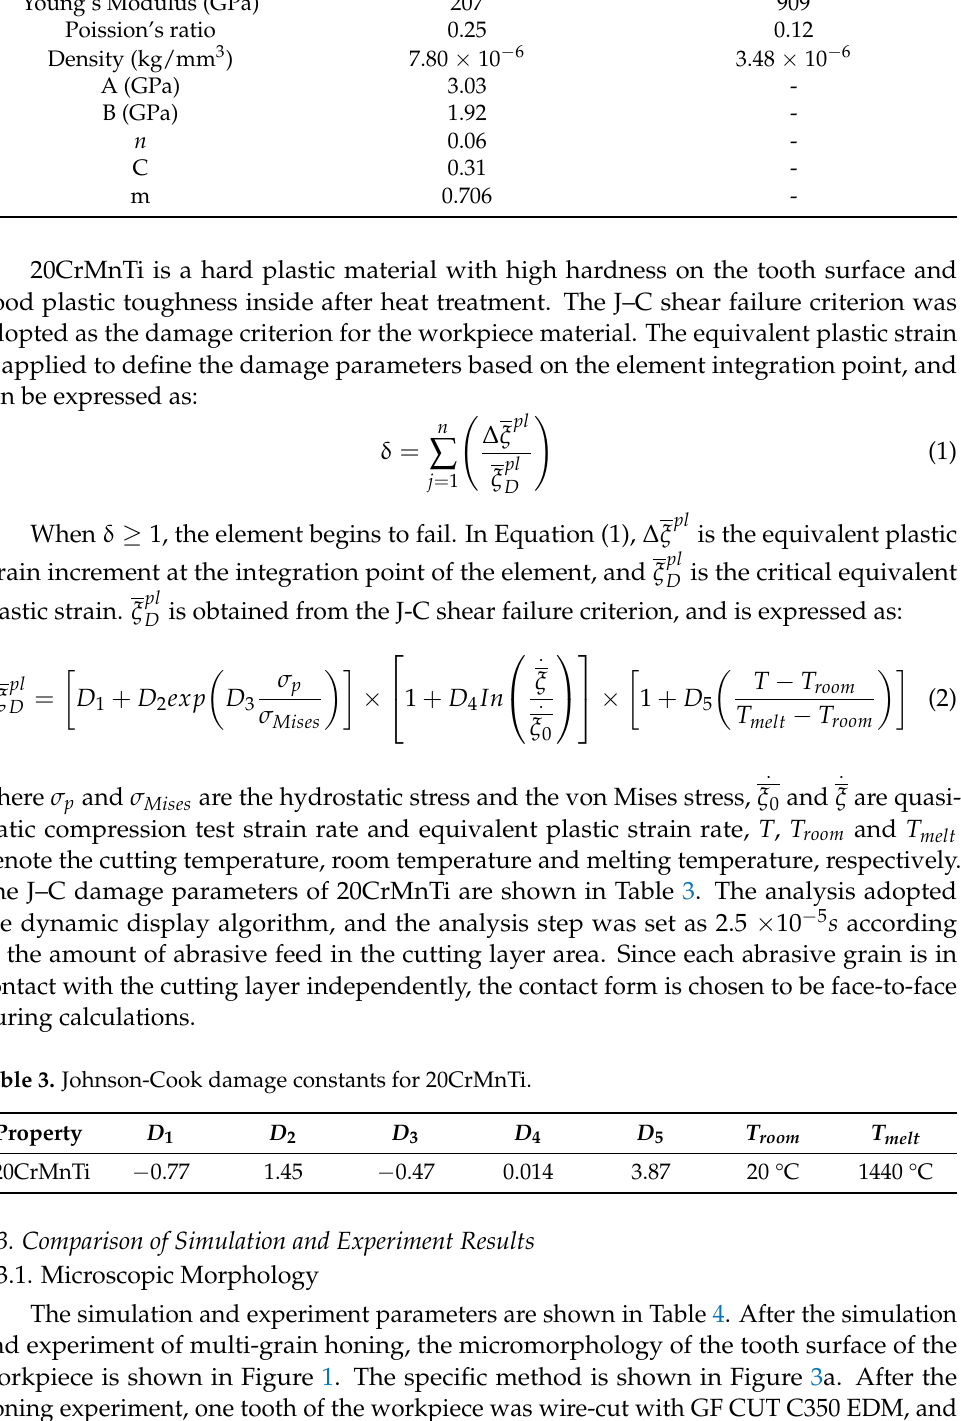
Table 2. Johnson–Cook plastic model constants for different materials. Property